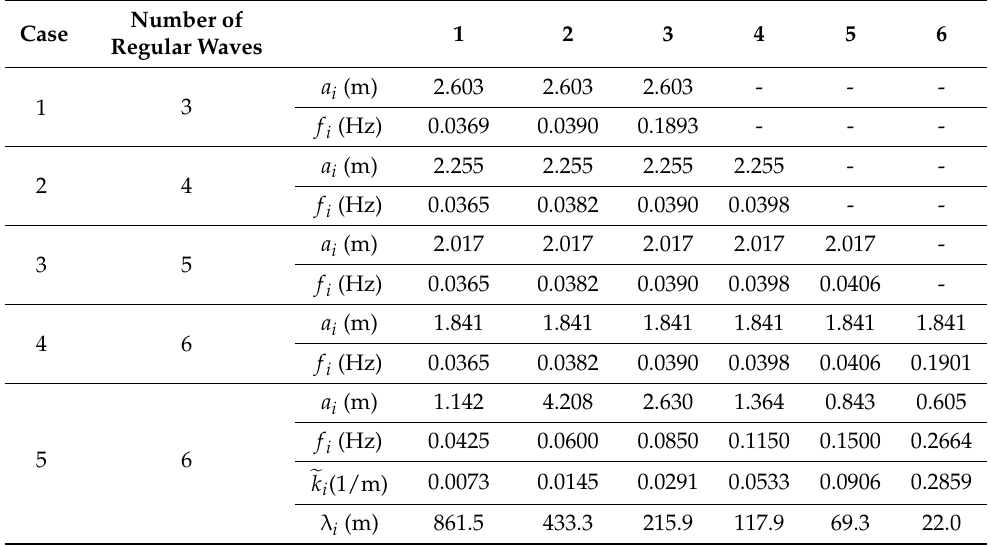
Table 1. Irregular wave simulated by regular waves [ H s = 15.4 m, P w = 16.5 s, n = 6, H bed = 1300 m].